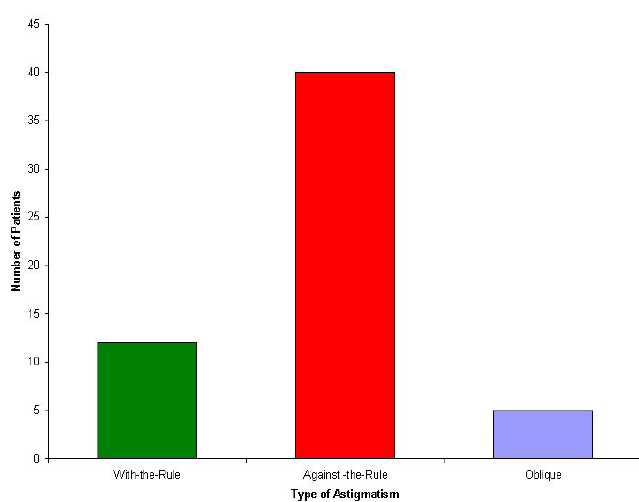
Figure 3 Number of patients with types of astigmatism